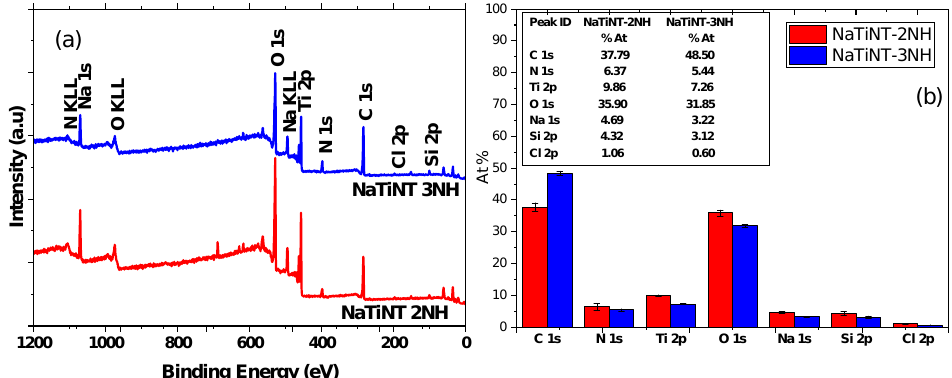
Figure 4. ( a ) Full scan X-ray photoelectron spectroscopy of the samples (NaTiNT − 2NH and NaTiNT − 3NH) and ( b ) XPS elemental quantification results of the samples.